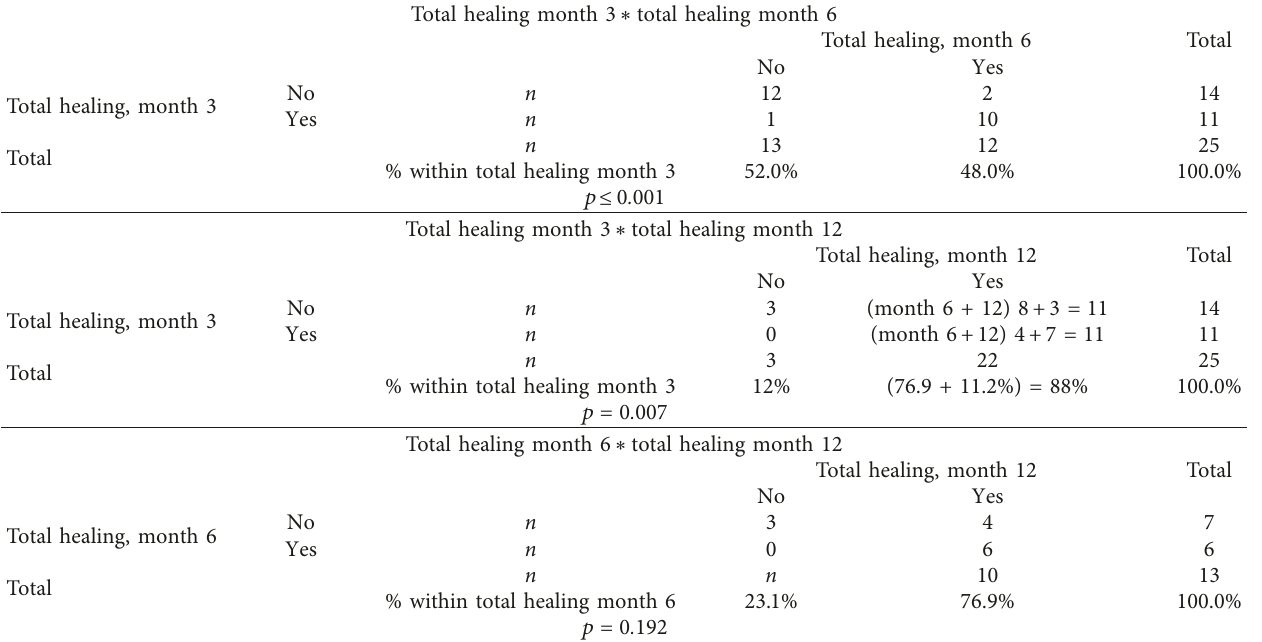
Table 5: Statistic calculation of the patient’s variables including cross-tabulation of total healing data in between treatment